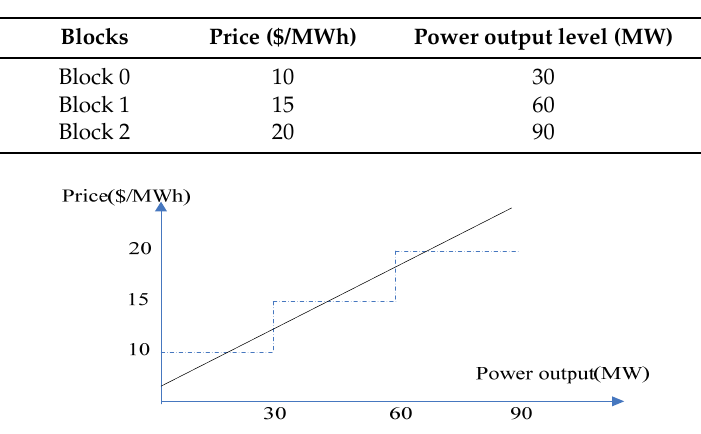
Figure 1. Block bid and continuous bid curves.